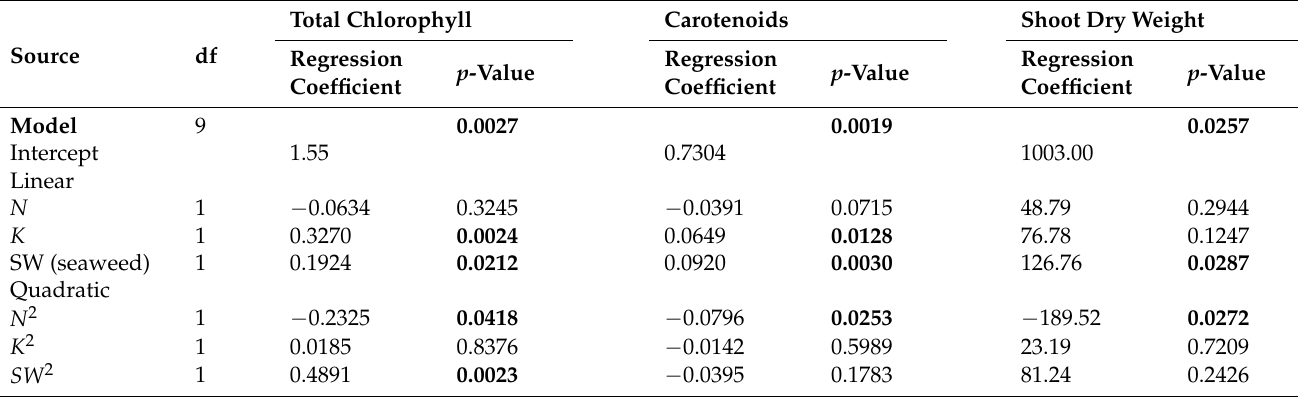
Table 4. Analysis of variance, regression coefficients, and adequacy criteria of the fitted models for total chlorophyll, carotenoids, and shoot dry